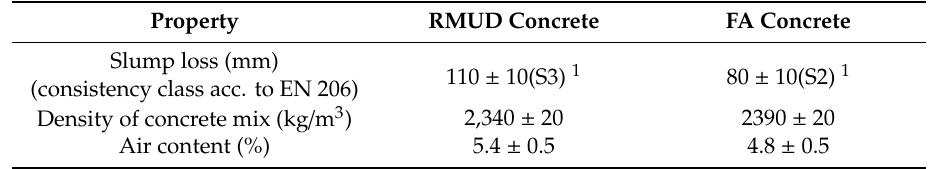
Table 4. Properties of concrete mix.